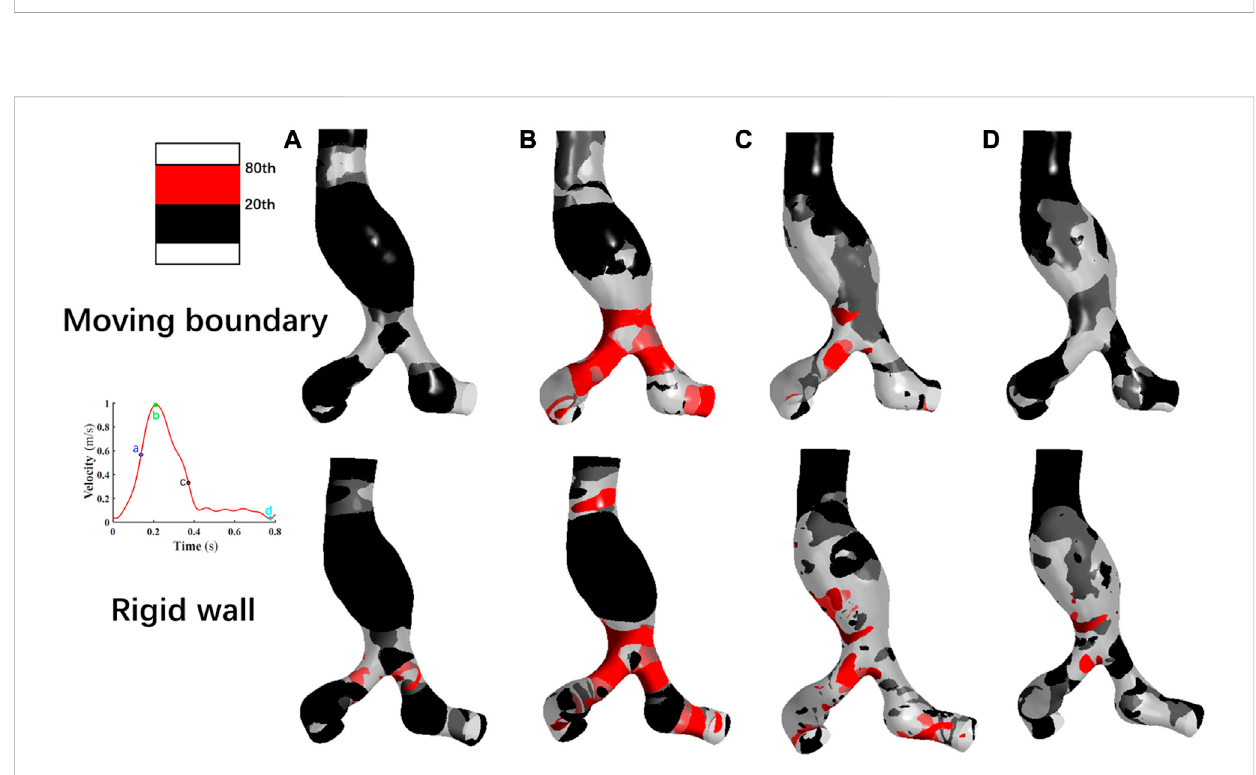
FIGURE 8 Comparison of the wall shear stress distribution at four speci fi c time points by using two methods. (A) : Time moment of maximum acceleration of velocity, (B) : Time moment of maximum velocity, (C) : Time moment of maximum deceleration of velocity and (D) : Time moment of minimum velocity.